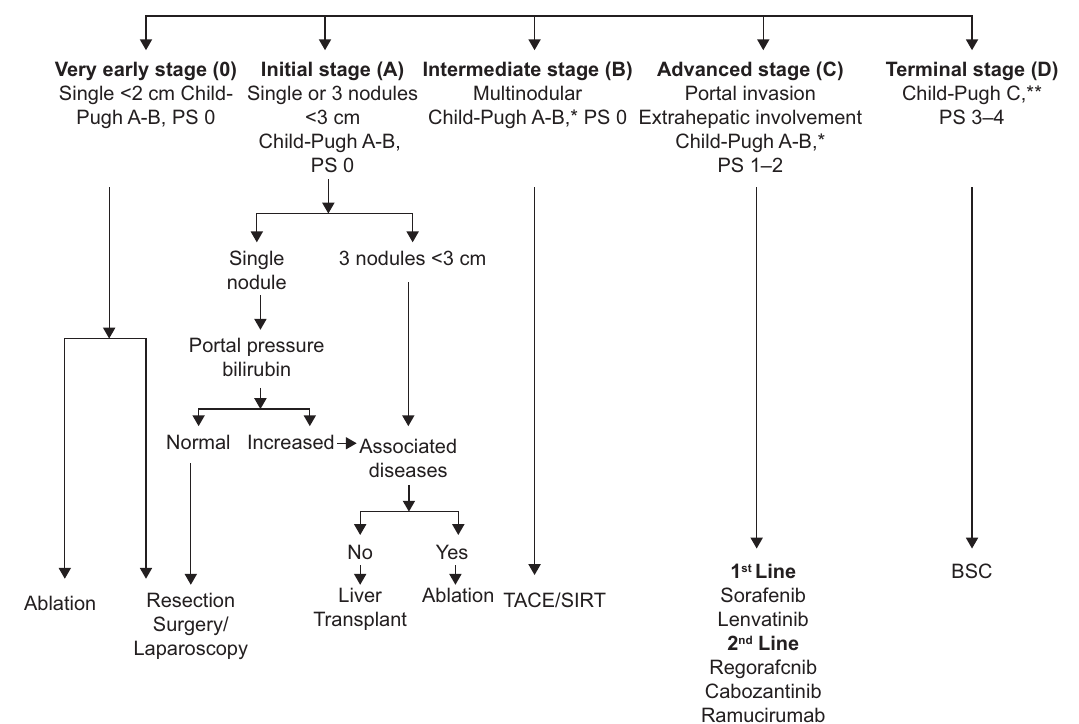
Figure 3: The Barcelona Clinic Liver Cancer (BCLC) staging system. PS: performance